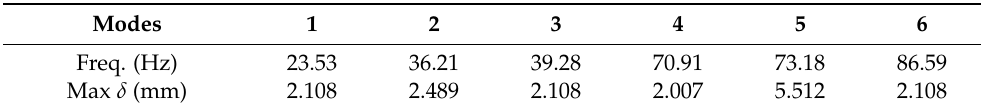
Table 6. The first six natural frequencies of the supporting frames are listed in this table, along with the maximum deformation associated with the harmonic